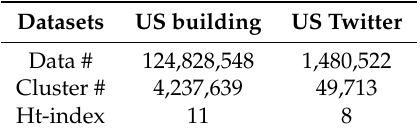
Table 3. Statistic of two datasets at country